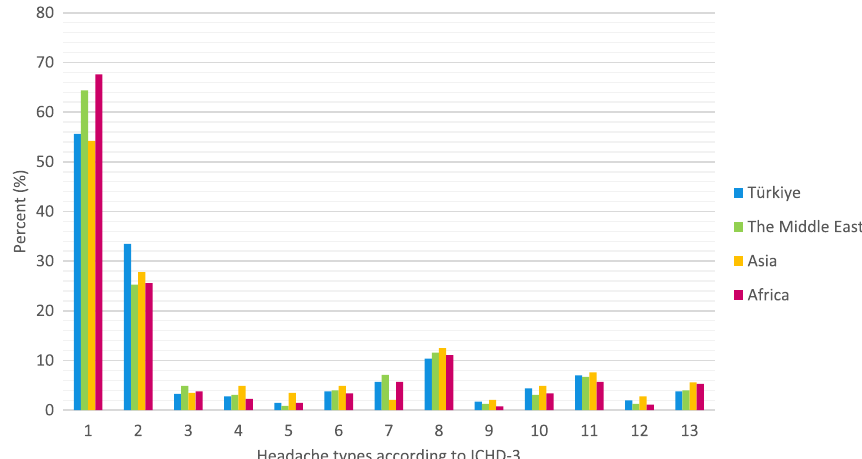
Fig. 4 Distribution of headache types according to regions (1; Migraine, 2; TTH, 3; TACs, 4; Other primary headache disorders, 5; Headache attributed to trauma or injury to the head and/or neck, 6; Headache attributed to cranial or cervical vascular disorder, 7; Headache attributed to non‑vascular intracranial disorder, 8; Headache attributed to a substance or its withdrawal, 9; Headache attributed to infection, 10; Headache attributed to disorder of homeostasis, 11; Headache or facial pain attributed to disorder of the cranium, neck, eyes, ears, nose, sinuses, teeth, mouth or other facial or cervical structure, 12; Headache attributed to psychiatric disorder, 13; Painful lesions of the cranial nerves and other facial pain)